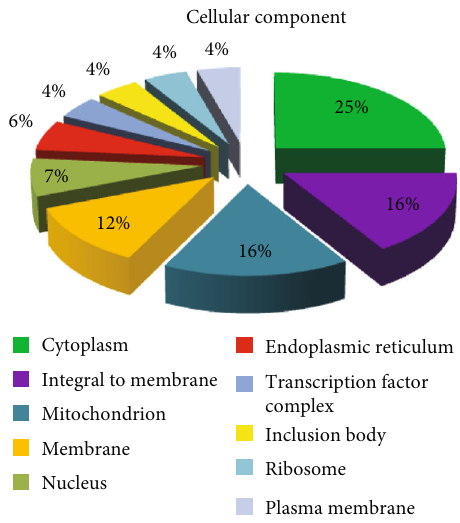
Figure 10: Gene Ontology (GO) distributions for reniform nematode genomic sequences as determined by Blast2GO and grouped by cellular component for the REPLI-g